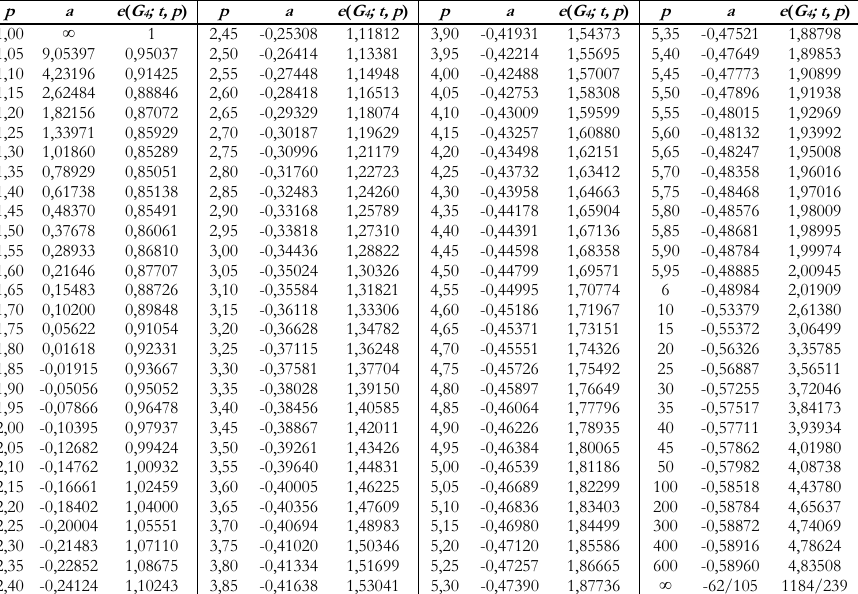
Values of a (b=1) maximising the Pitman efficiency e(G 4 ; t,